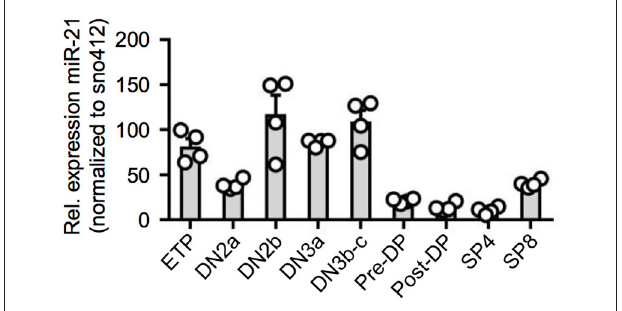
FIGURE 1 | Dynamic expression of miR-21 during T-cell development. Quantitative RT-PCR for miR-21 expression in sorted thymic subsets from WT mice. Expression levels of indicated cell populations were normalized to snoRNA412. Each dot represents one mouse, n = 4.